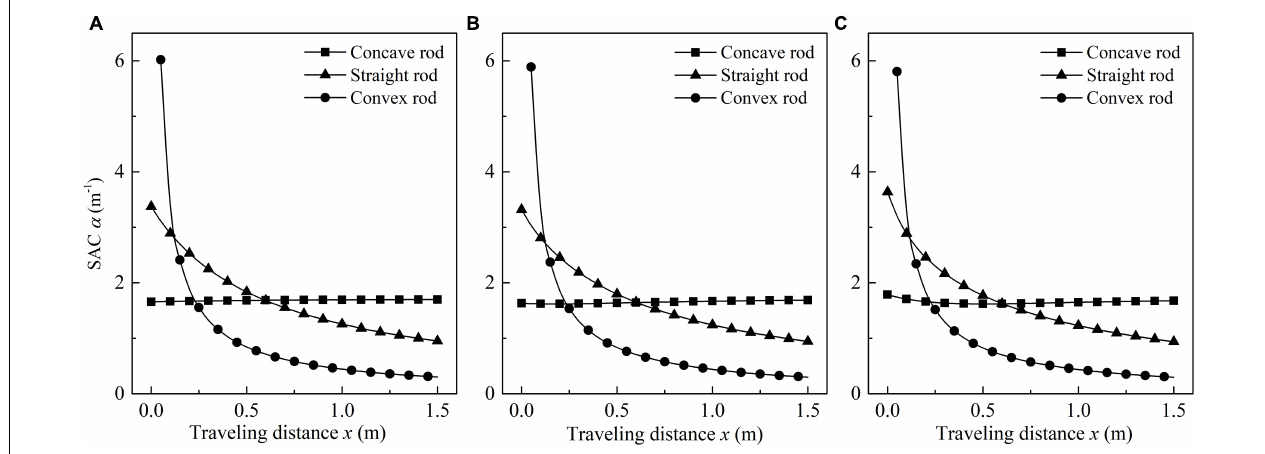
FIGURE 10 | Spatial attenuation coefficient versus traveling distance in concave, straight and convex rock bars ( r 0 = 0.025 m, r L = 0.09 m, ω = 628.3 Hz) (A) σ